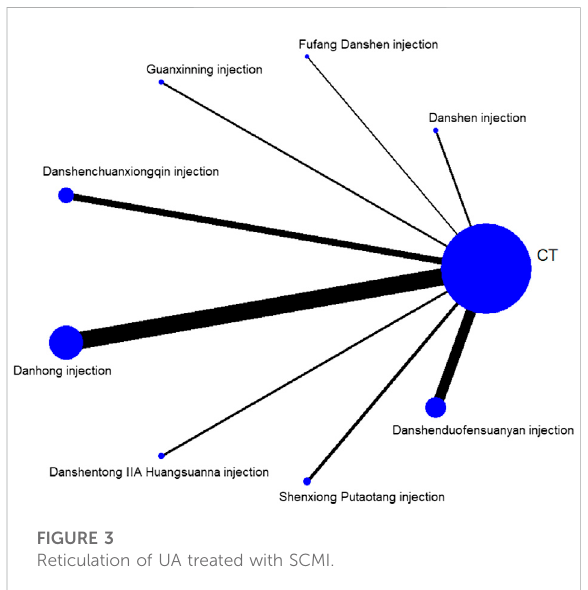
FIGURE 3 Reticulation of UA treated with